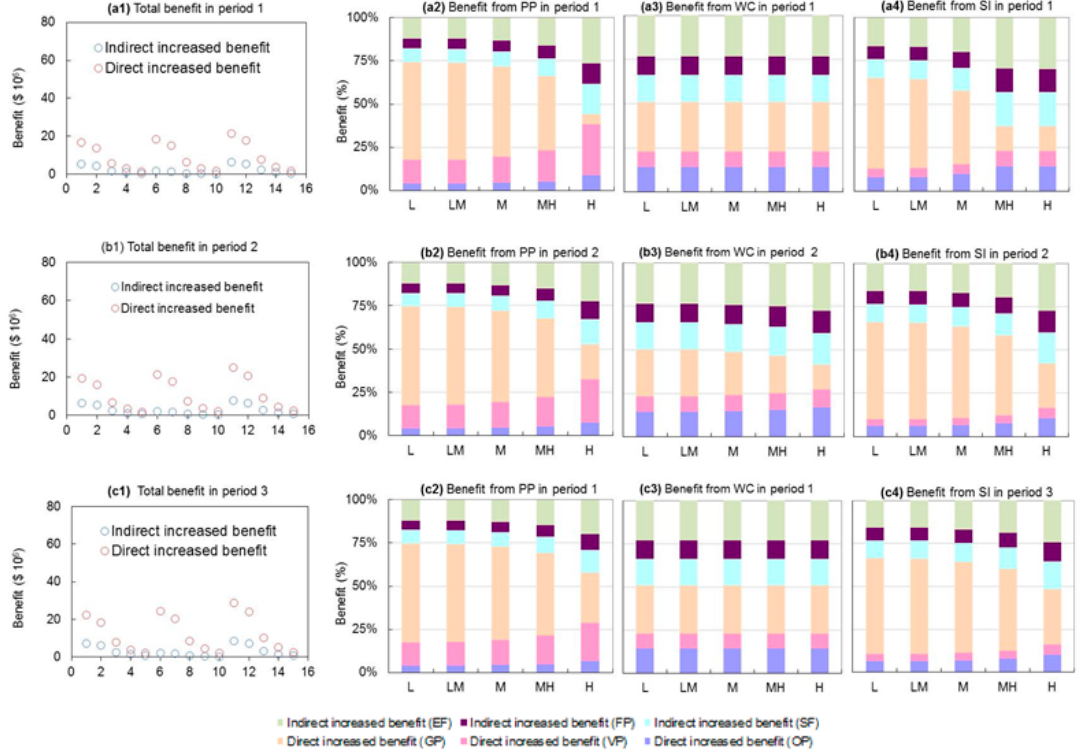
Figure 5. Ecological benefits from AEP under case 1 when µ level is 0.99.